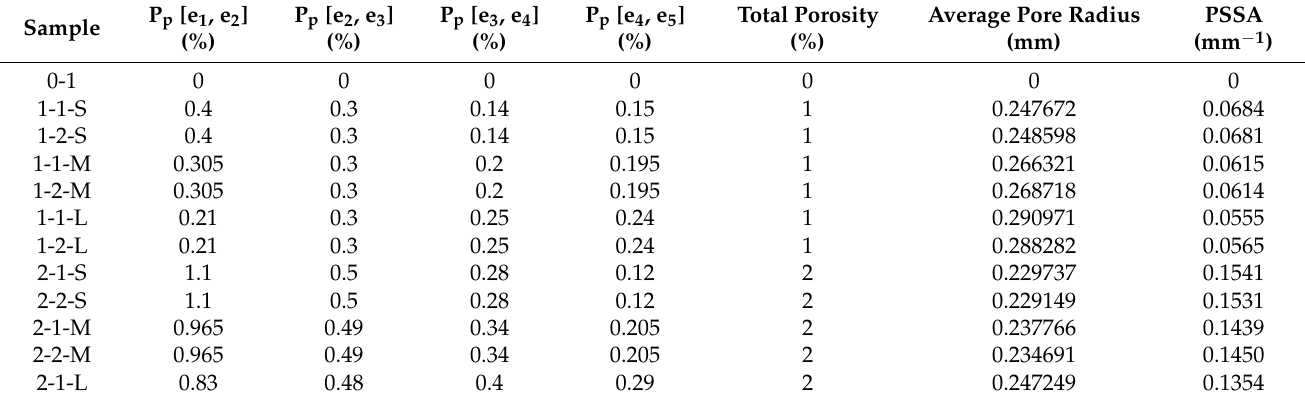
Table 2. Concrete specimens and pore structure